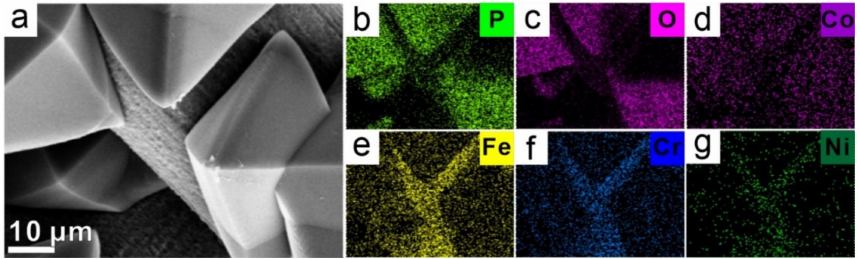
Figure 3. SEM image of ( a ) 0.84-CoFePi, and EDS elements mapping of 0.84-CoFePi ( b ) P, ( c ) O, ( d ) Co, ( e ) Fe, ( f ) Cr, and ( g )